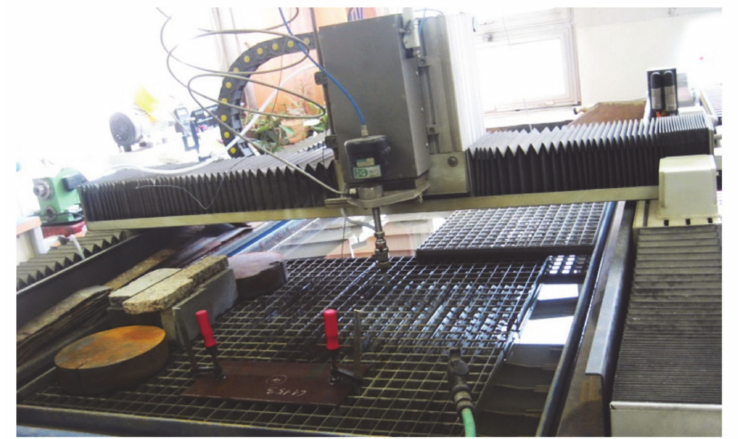
Figure 1. Experimental system with water jet technology in the laboratory of liquid